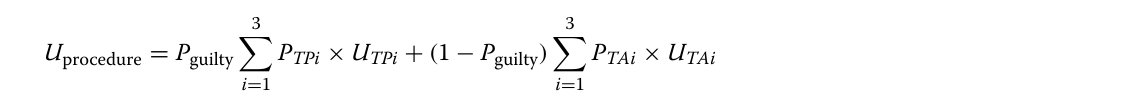
Table 5 Outcome percentages and utilities for the sequential lineup and showup conditions (data from Wilson et al., 2019)